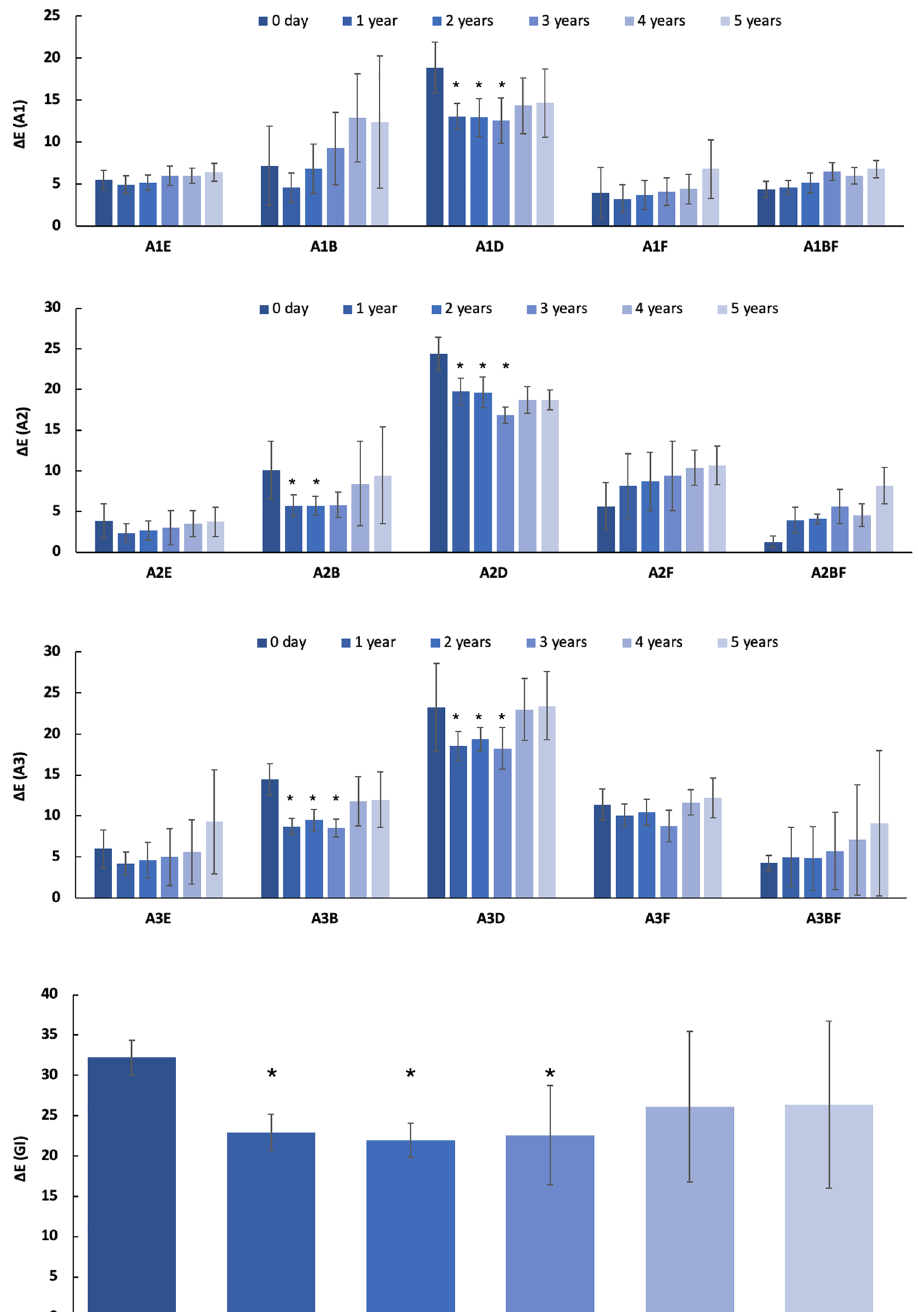
Figure 3. The ∆E between each restorative material and its adjacent ceramic across 5 years. *Indicates significant difference compared with Day 0 ( p <